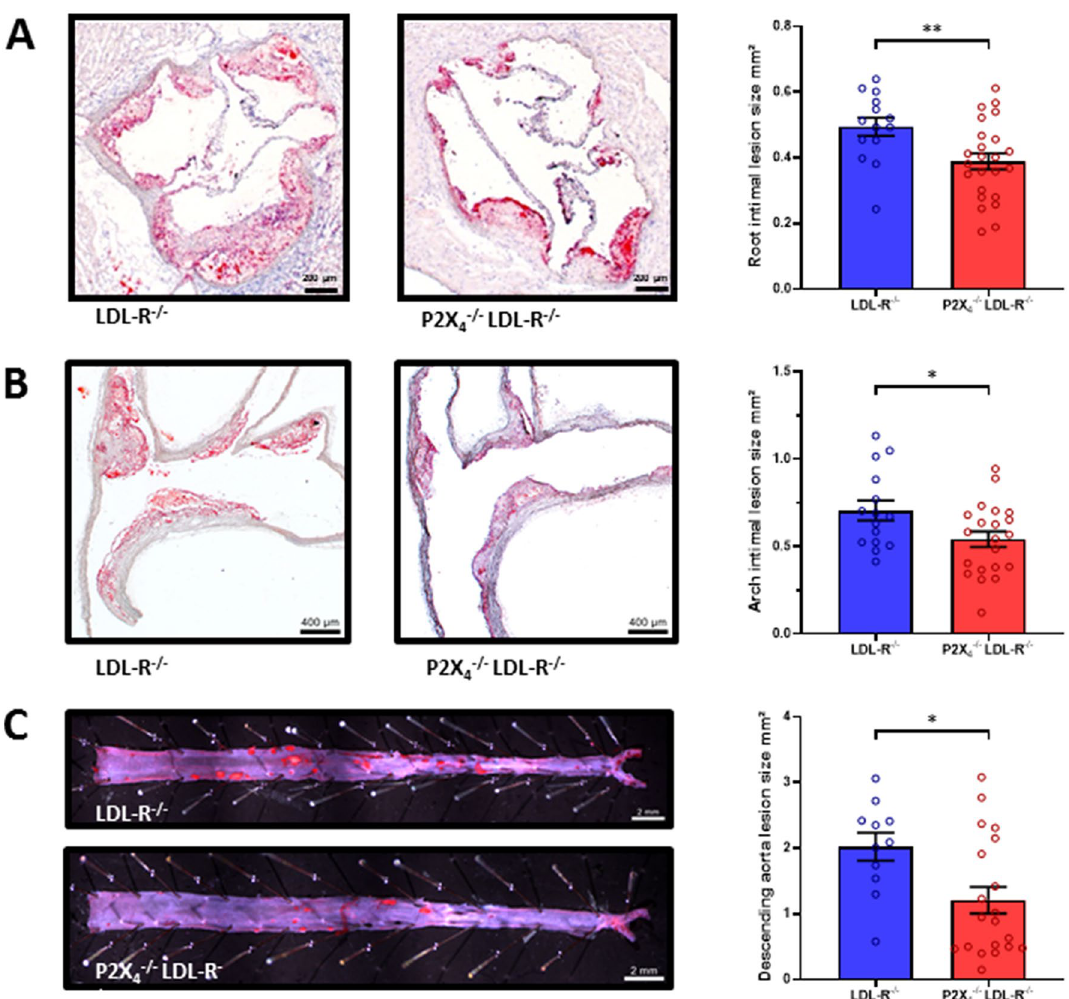
Figure 2. P2X 4 -deficiency reduces atherosclerosis. P2X 4 −/− LDLR −/− mice (n = 24) and P2X 4 +/+ LDLR −/− mice (n = 14) were fed a high-cholesterol diet for 16 weeks. Atherosclerotic lesion size in aortic roots ( A ), aortic arches (P2X 4 −/− LDLR −/− n = 21, P2X 4 +/+ LDLR −/− n = 15) (B ) and abdominal aortas (P2X 4 −/− LDLR −/− n = 20, P2X 4 +/+ LDLR −/− n = 11) ( C ) was determined by histochemistry, representative images are shown. Results are presented as mean ± SEM. Statistical significance was calculated using unpaired t-test (parametric) or Mann–Whitney -U - test (non-parametric data). * p < 0.05; ** p < and abdominal aortas was determined histochemically. P2X 4−/− LDLR −/− mice developed significantly smaller atherosclerotic lesions in the aortic root (P2X 4+/+ LDLR −/− : 0.49 ± 0.11mm 2 , n = 15; P2X 4−/− LDLR −/− : 0.39 ± 0.12 mm 2 , n = 24; p < 0.01; Fig. 2A) and the aortic arch (P2X 4+/+ LDLR −/− : 0.71 ± 0.22mm 2 , n = 15; P2X 4−/− LDLR −/− : 0.54 ± 0.21mm 2 , n = 21; p < 0.05; Fig. 2B). Moreover, intimal lesion size in the abdominal aorta was significantly reduced in P2X 4−/− LDLR −/− mice compared to control (P2X 4+/+ LDLR −/− : 2.02 ± 0.7mm 2 , n = 11; P2X 4−/− LDLR −/− : 1.21 ± 0.9mm 2 , n = 20; p < 0.05; Fig. 2C). Compared with the control group, P2X 4−/− LDLR −/− mice had lower leu- kocyte counts before diet, whereas leukocyte counts after diet were slightly higher in the P2X 4−/− LDLR −/− group (Table 1). In the differential blood count a lower proportion of total t-cells, CD4+ T cells and a higher propor- tion of CD8+ T cells were phenotypically observed in P2X 4−/− LDLR −/− mice, both before and after diet (Table 1). Interestingly, the analysis of monocyte subgroups revealed that P2X 4−/− LDLR −/− mice shared a lower propor- tion of pro-inflammatory Ly6C high monocytes and a higher proportion of anti-inflammatory Ly6C low monocytes before and after the diet (Table 1). However, no significant differences in the proportion of common myeloid progenitor cells were found in the bone marrow between P2X 4 -deficient and P2X 4 -competent mice (Supplemen- tal Table 1). There were no other differences in the differential blood count, triglycerides and cholesterol. Health status, weight, life span, behavior, and reproduction did not differ between both groups. Altogether, these find- ings indicate a lower inflammatory burden in P2X 4−/− animals. P2X does not influence plaque composition in atherosclerotic lesions. Plaque composition plays 4 an important role in advanced human atherosclerotic lesions with regard to possible plaque rupture. Thus, we further assessed crucial features of atherosclerotic plaque composition by histochemistry. Analysis of plaque